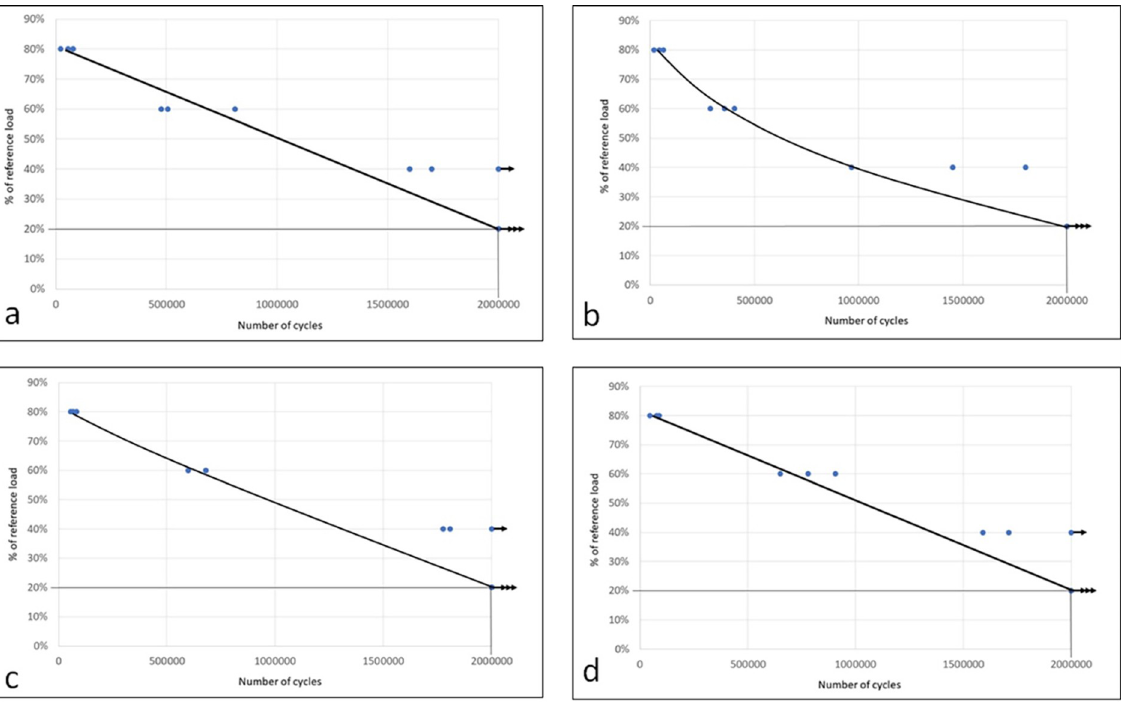
Fig 9. Graph images of the number of cycles supported by the samples of each group during the 4 applied load levels: (a) MT group, (b) Collo out group, (c) Collo bl group, and (d) EH con group.